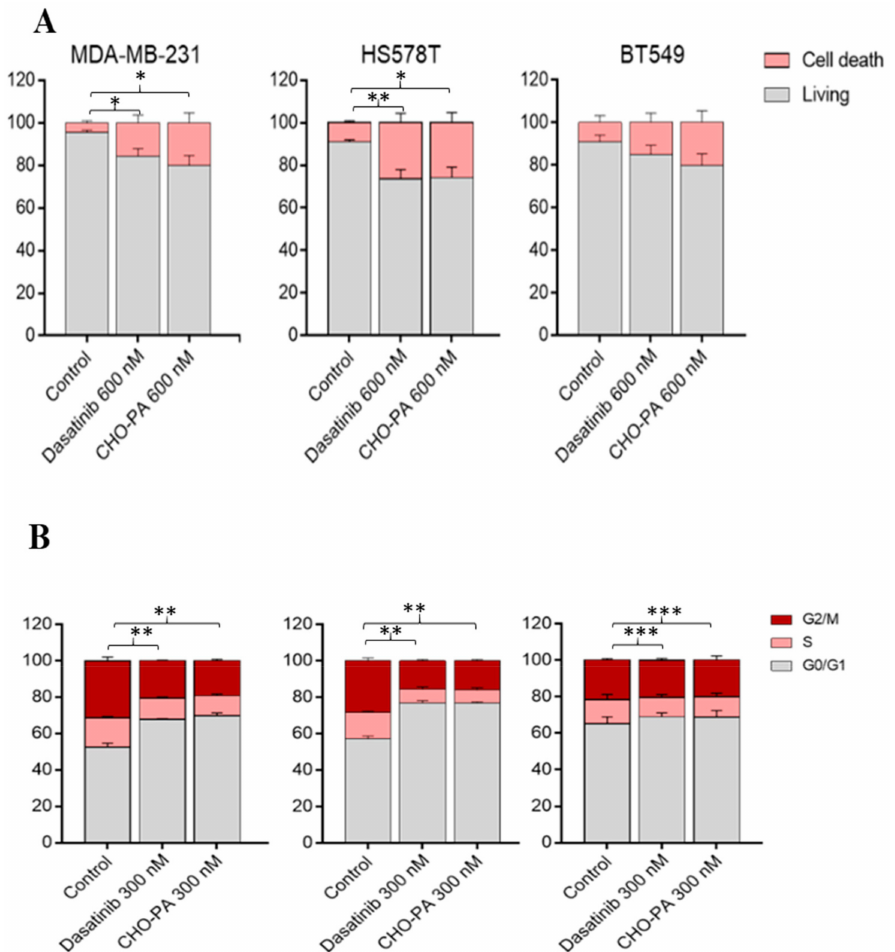
Figure 7. E ff ect of DAS and CHO / PA in TNBC cell lines. ( A ). Apoptotic e ff ect of dasatinib and CHO / PA in MDA-MB-231, HS578T and BT549. Cells were stained with Annexin V after 72 h of treatment. ( B ). E ff ect in cell cycle. Graphical representation. Cells were treated with 600 nM of DAS and CHO / PA. Cell cycle progression was analyzed after 24 h of treatment by flow cytometry using propidium iodide DNA staining. Data are expressed as mean ± s.e.m. from at least three independent experiments. p < 0.05* p < 0.01** p <